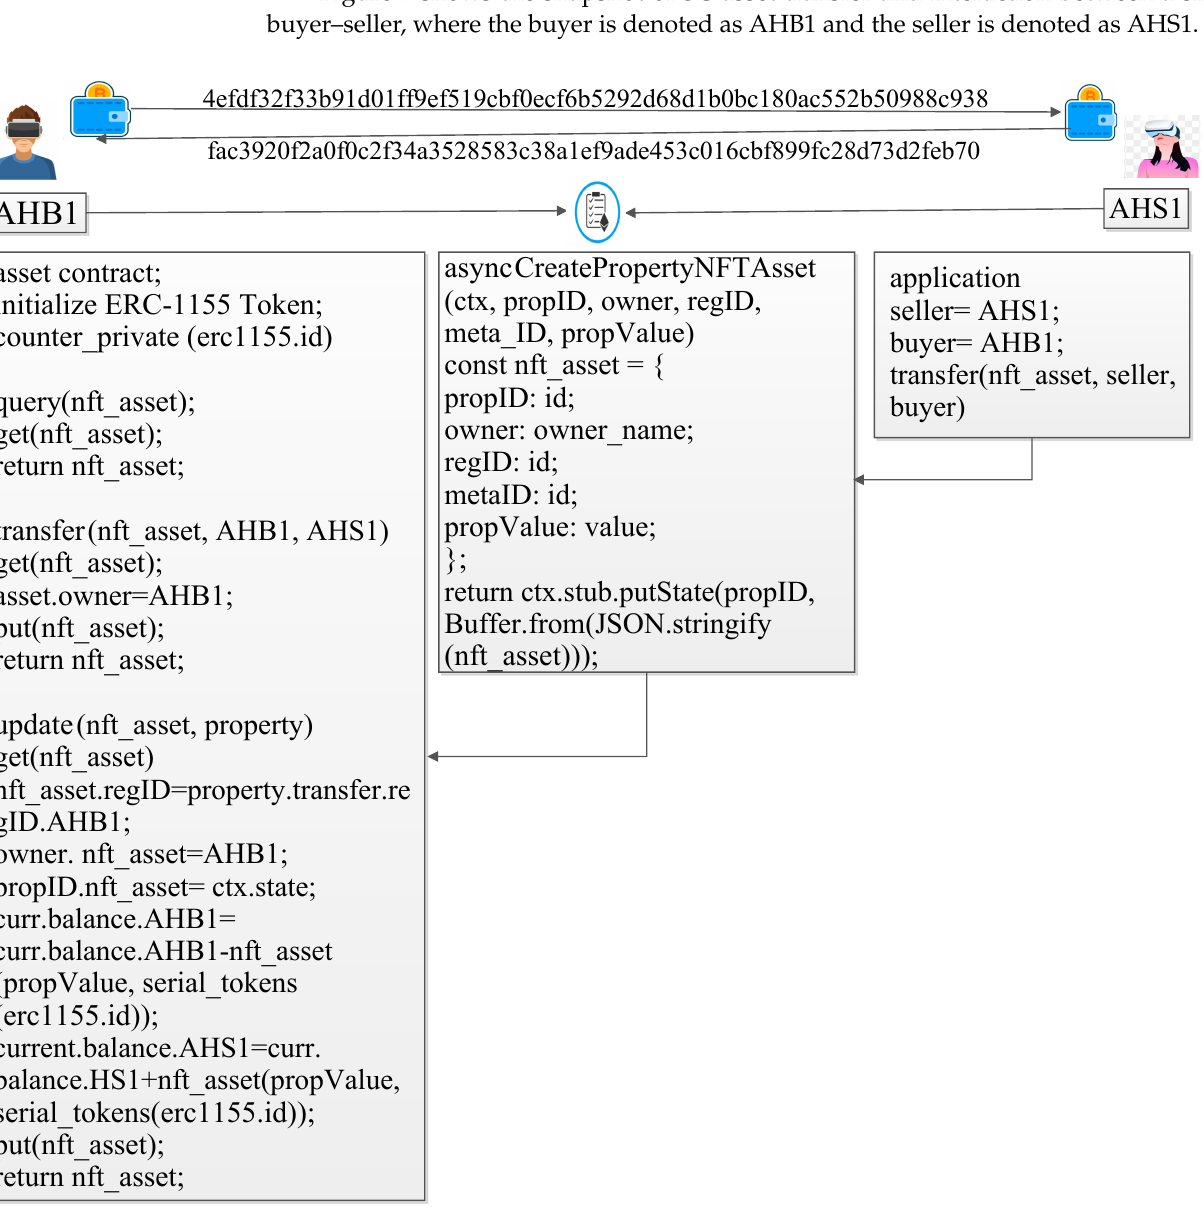
Figure 7. Snapshot of SC asset transfer for the BBS REM